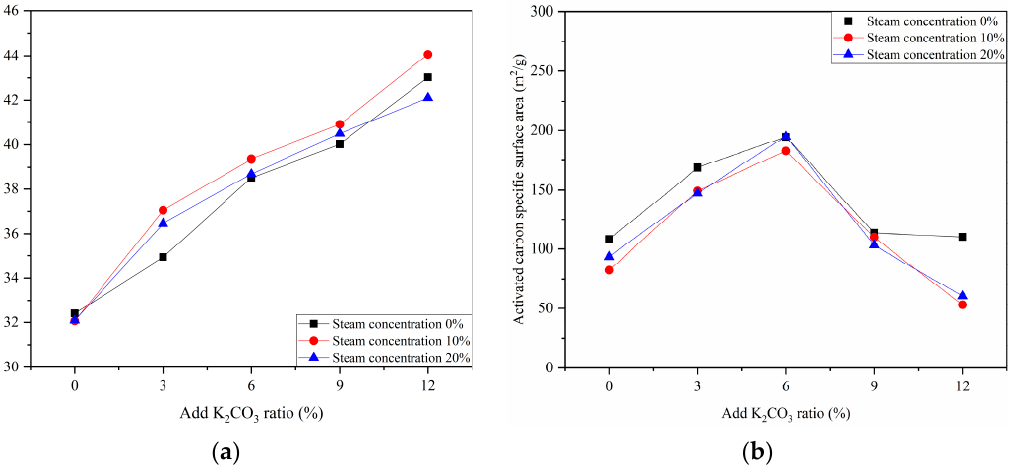
Figure 7. Variation trend of activated carbon yield and specific surface area with the addition ratio of K 2 CO 3 : ( a ) activated carbon yield and ( b ) activated carbon-specific surface area.